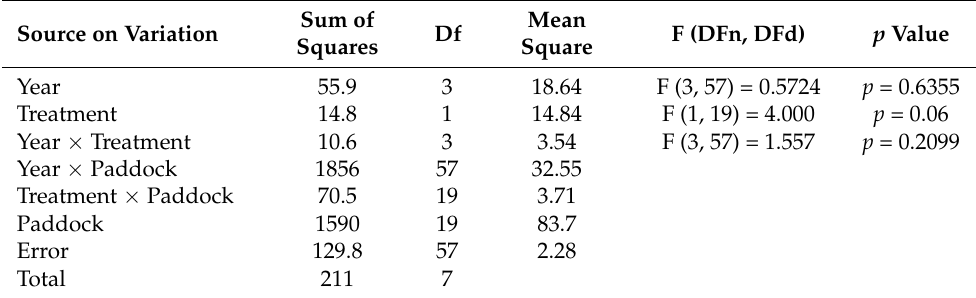
Table A7. Intra-annual Enhanced Vegetation Index (EVI) Variability two-way repeated measure ANOVA of natural grassland, 4 years before to intensification practice ( n = 20).